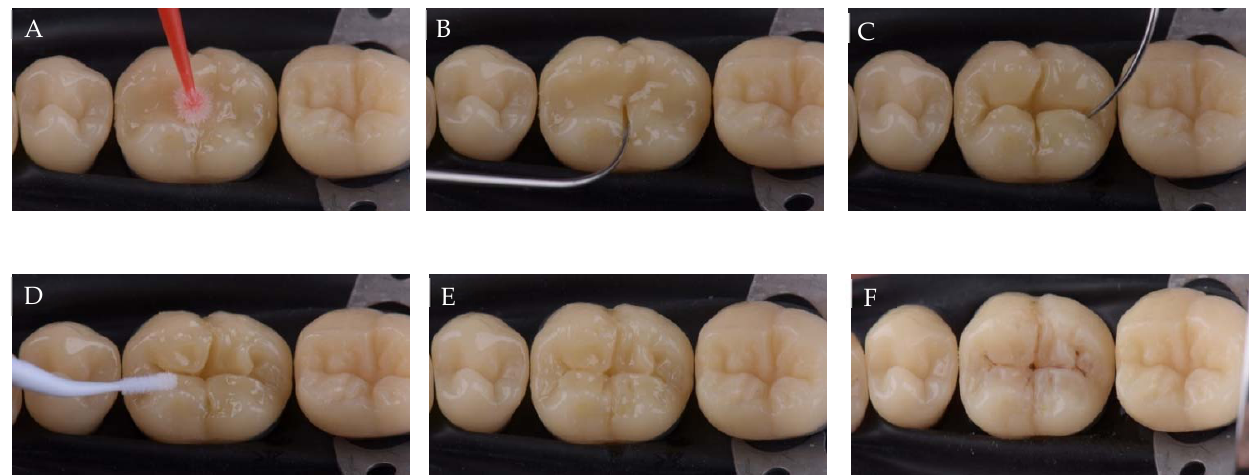
Figure 1. FMBT on class I molar cavity. ( A ) Bulk-fill adaptation using micro-brush; ( B ) first cut of the composite following the remaining fissure with the help of LM Arte fissura; ( C ) drawing the fissures by cutting the composite following the remaining fissures and the anatomy of the teeth; ( D ) cusps were brought together in harmony using a microbrush by reducing the volume of the gap created by cutting the composite; ( E ) stains were applied to give the restoration some aesthetic and 3D appearance; and ( F ) final restoration.